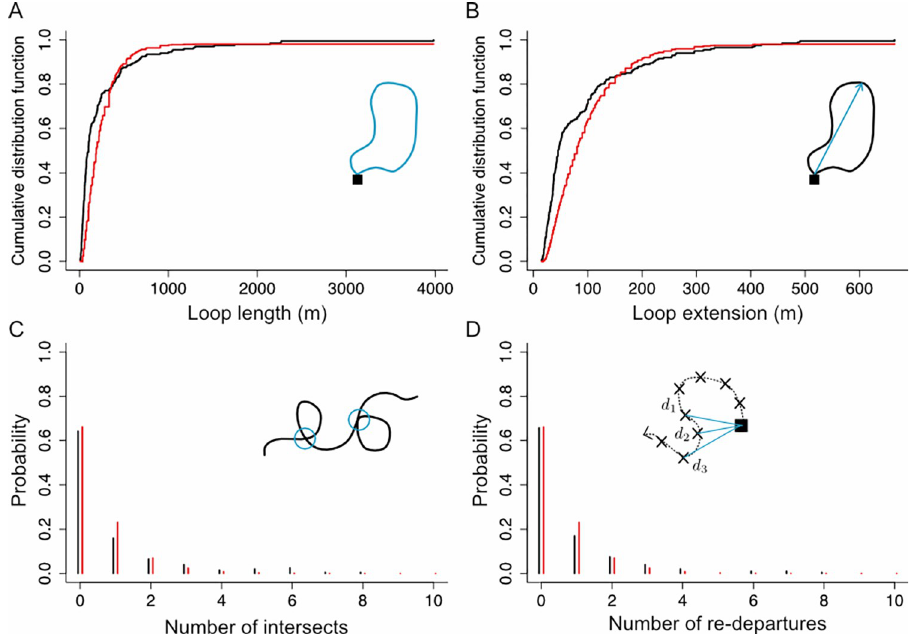
Fig 2. Distributions of the four observables, for experimental and simulated data. Black lines: experimental data. Red lines: model predictions using the optimal γ = 1.0 s − 1 , σ = 0.37 rad/s 1/2 , p return = 1/30 s − 1 and η * = 0.2 s -1 . Insets: Schematic of each observable. (A) Cumulative distribution function of loop lengths for our full dataset. (B) Same as A, but for the loops extension. (C) Probability distribution of the number of trajectories intersects per 100m traveled. (D) Same as C, but for the number of re-departures per 100 m